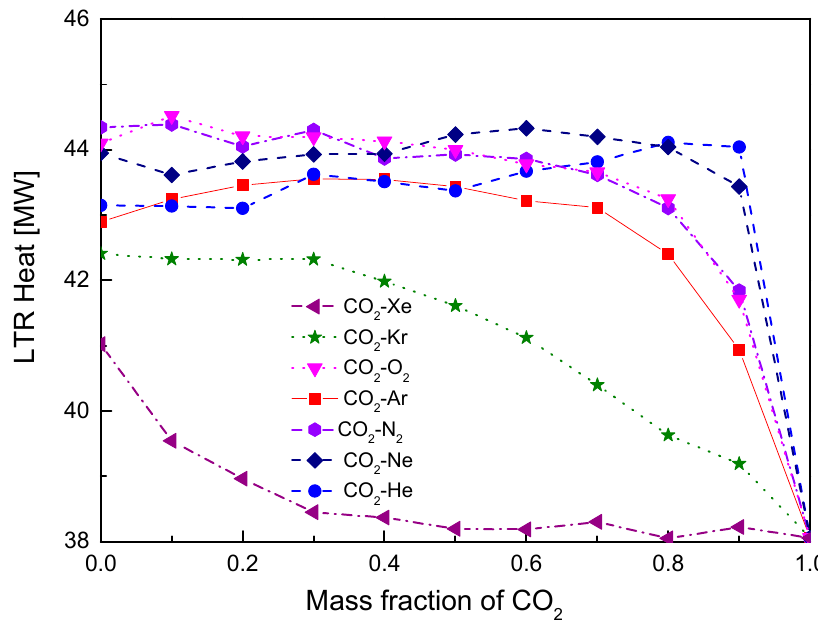
Figure 15. Low-temperature recuperator (LTR) heat of mixtures at different mass fractions of CO 2 .